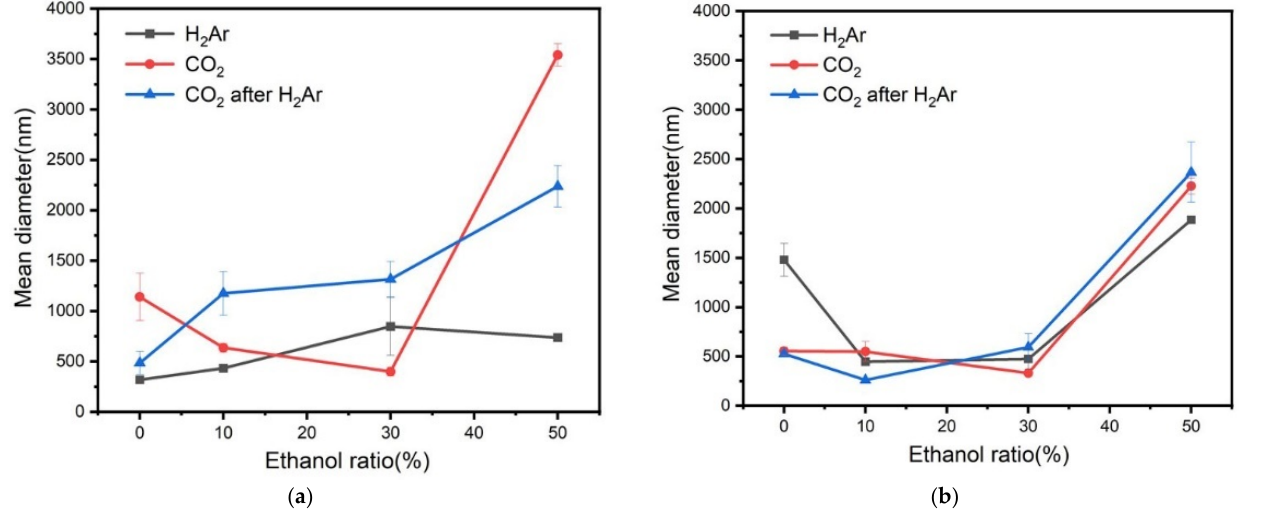
Figure 3. Mean diameter of several nanobubbles in ethanol aqueous solution at pH 9 after ( a ) 1 and ( b ) 20 days.